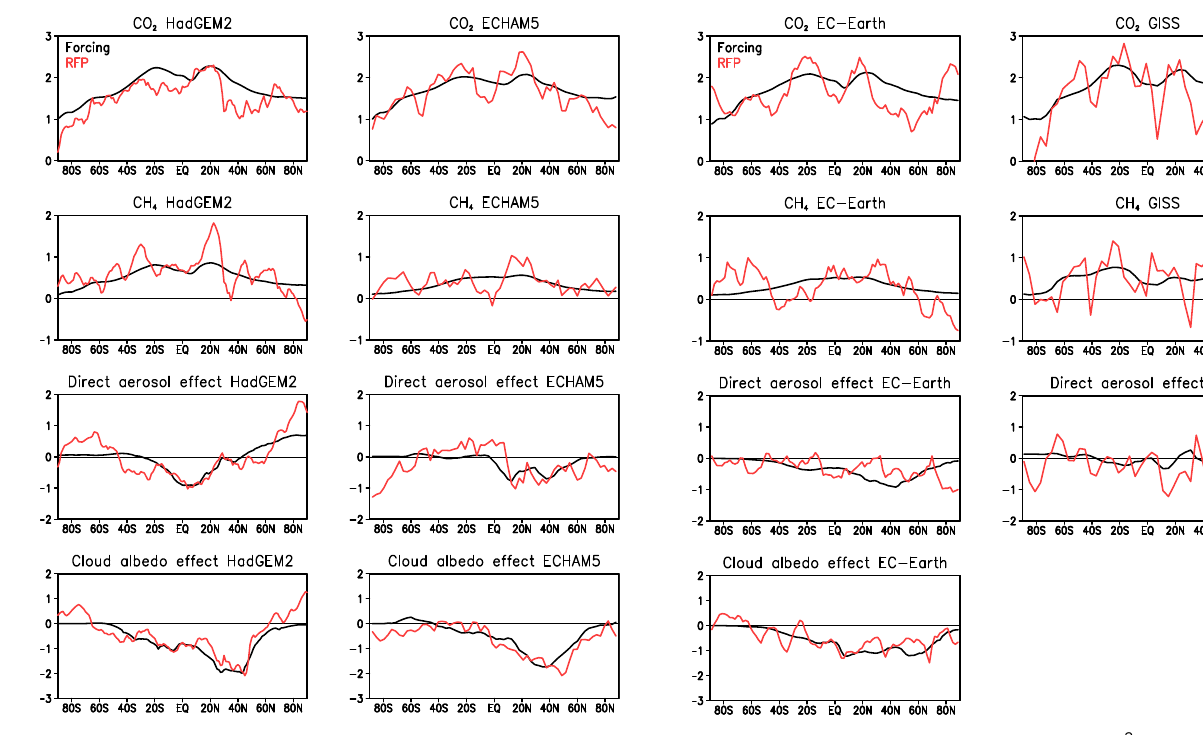
Fig. 4. Annual zonal means of RFP vs. F [Wm − 2 ] for the different forcing agents from the HadGEM2 and ECHAM5 GCMs.